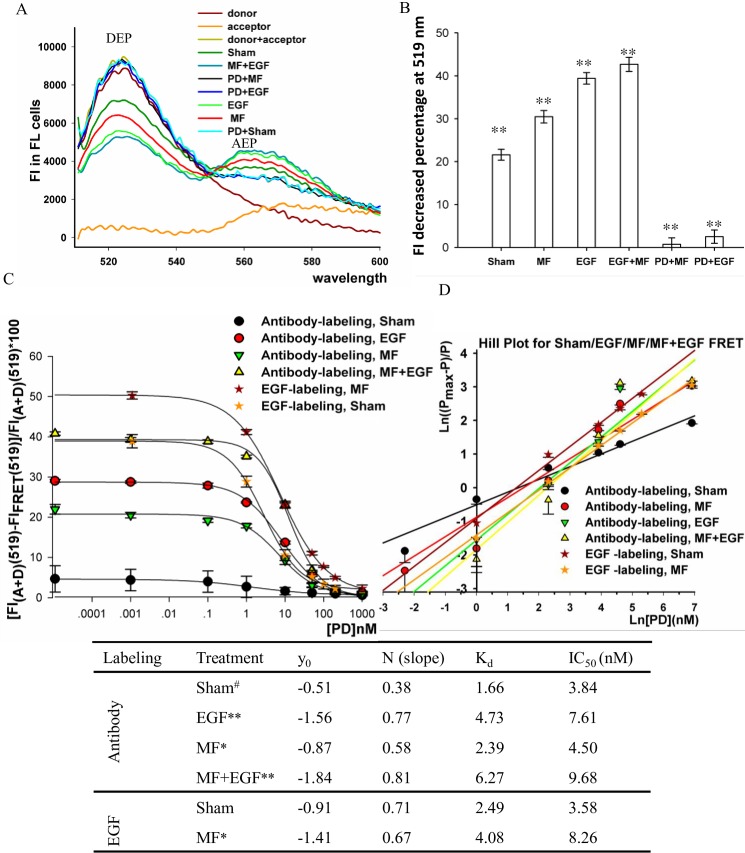
MF induced EGFR interaction.A: Fluorescence intensity of EGFR in differently treated FL cells. The plots represent the FI along wavelength in FRET groups of FL cells treated with sham exposure for 30 min (Sham), 0.4 mT 50 Hz MF for 30 min (MF), 100 nM EGF for 30 min while sham exposed (EGF) or 0.4 mT 50Hz MF exposed (MF+EGF), or pretreated with 1 μM PD for 2 h before 30 min treatment of 100 nM EGF (PD+EGF) or 0.4 mT 50 Hz MF (PD+MF). When cells were labeled with only donor dye (donor) or only acceptor dye (acceptor), the indicated treatment did not change the FI, thus only one single plot was shown as example; donor + acceptor: the mathematically sum of the FI in the donor and in the acceptor. DEP: Donor’s emission peak; AEP: Acceptor’s emission peak. B: Quantification of the FI decreases at donor emission peak from A. **: p-value < 0.01 in MF, EGF, and MF+EGF group when compared with Sham by Student’s t-test. C: The DEP FI decrease percentages in EGFR monomer solution with pretreatment of PD of a serial of concentration. D: Hill Plot analyses of the data in C; error bar was representative of Ln(mean-sd); more details seen in Materials and Methods. E: Kd and IC50 of PD inhibition to purified EGFR proteins upon different treatments by Hill plot; * and **: p-value < 0.05 and < 0.01, respectively, when compared to Sham with the same labeling; #: the error bars in this group (shown in C) were so high that the extracted values might not reflect the real case. The repeat time of the experiments was listed in S1 Table.